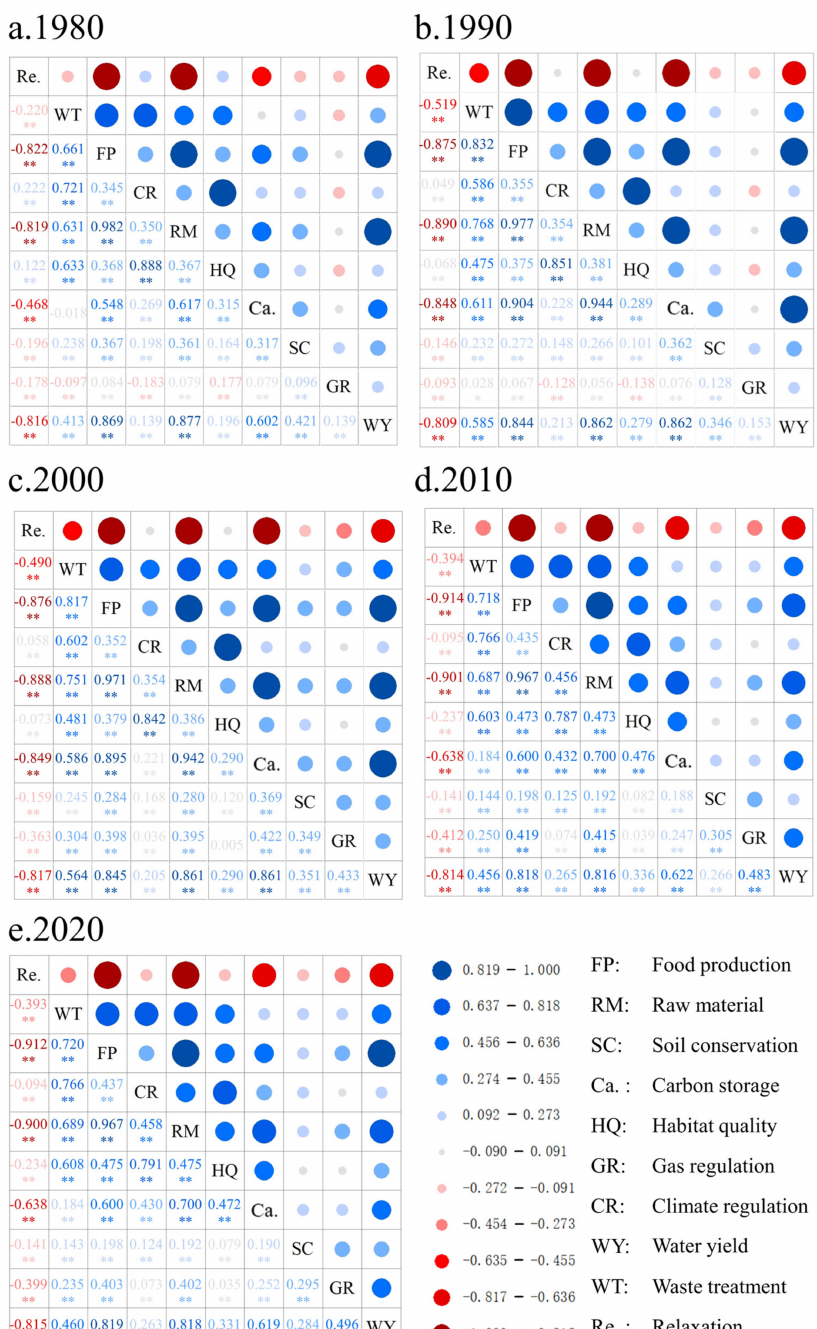
Figure 5. Correlations among 10 types of ecosystem services (** represents p < 0.01) in the Yellow River Delta, 1980–2020. The lower left part of each panel shows the Spearman’s correlation coefficients. The blue and red symbols represent positive and negative correlations,